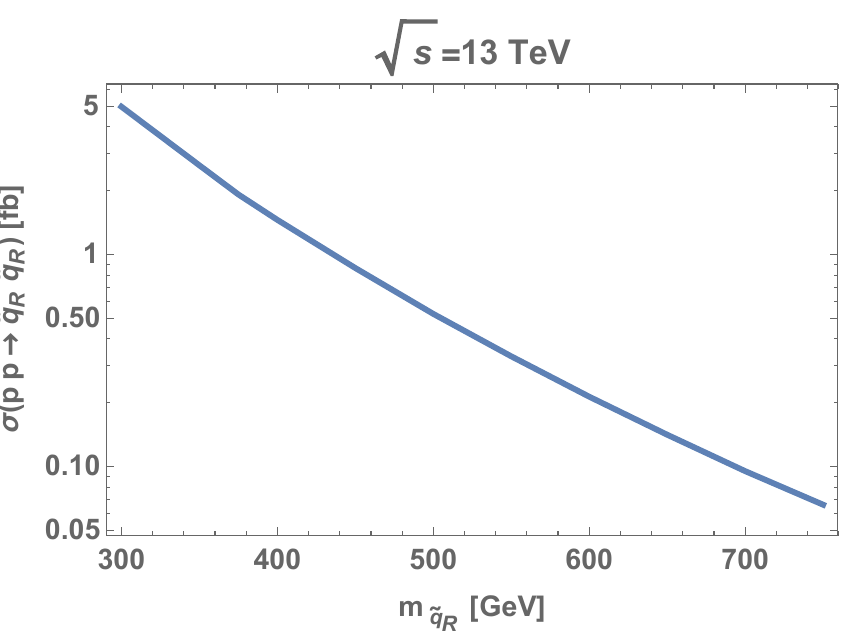
Figure 1 . Cross section for the production of right-handed f-squarks vs. their mass. We assume m ~ u = m ~ = m ~ c = m ~ s = m ~ . See text for d R b R R R R